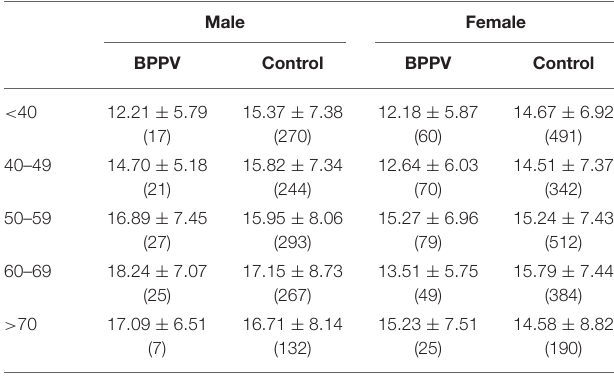
TABLE 1 | 25(OH)D levels (ng/ml) and number in subgroups divided by sex and age. Male